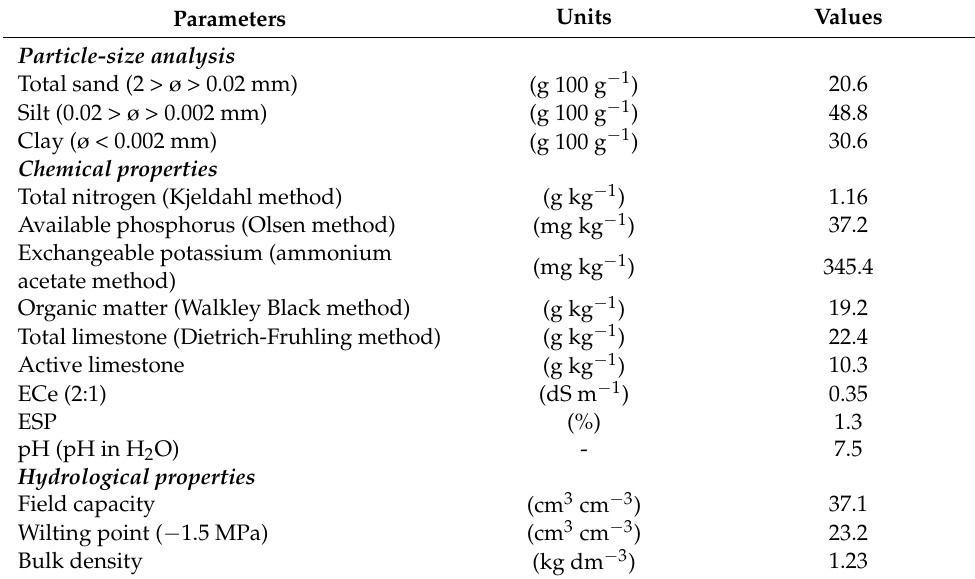
Table 1. Main physical, chemical, and hydrological characteristics of the